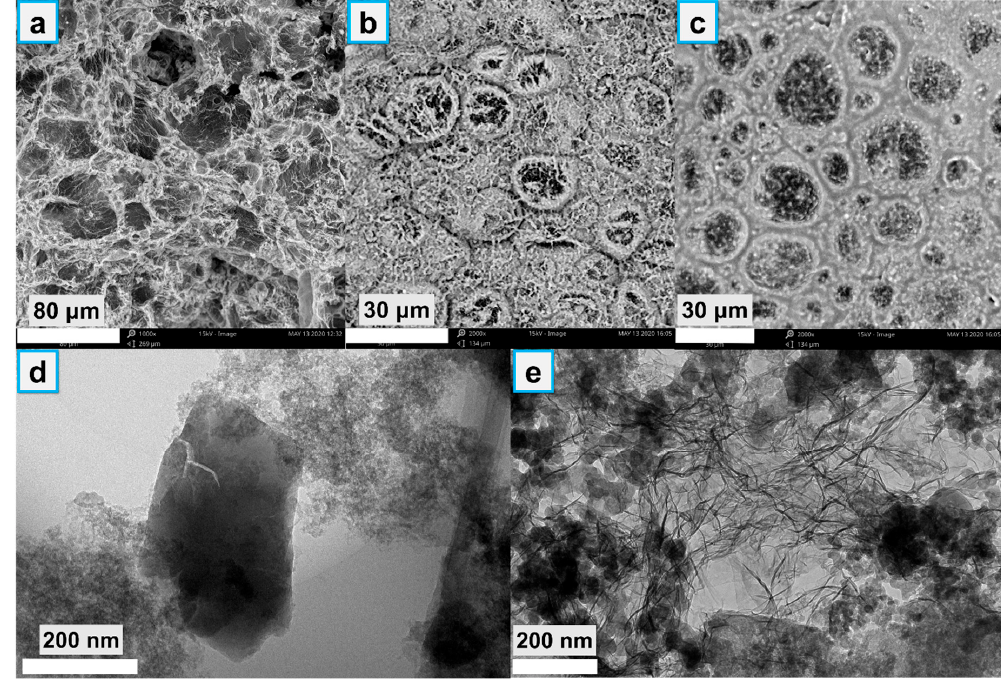
Figure 9. SEM photos of surface char layer of 25% APP/DPER ( a ), 25% APPZ1/DPER ( b ), 25% APPZ4/DPER ( c ); low-magnification TEM images of a surface char layer of 25% APP/DPER ( d ), and 25% APPZ4/DPER ( e )